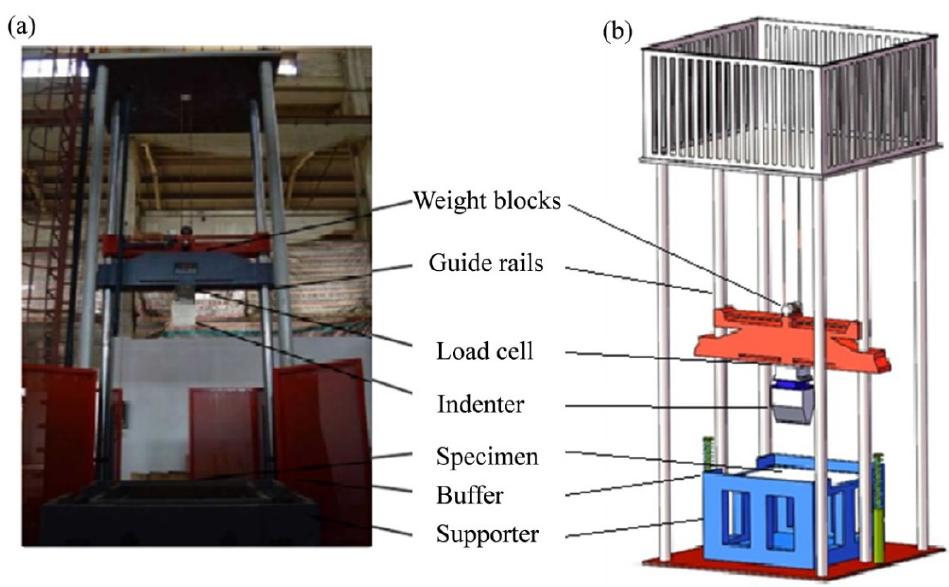
Figure 3. Schematic diagram of the falling weight impact tester: ( a ) Photograph; ( b ) Schematic diagram.